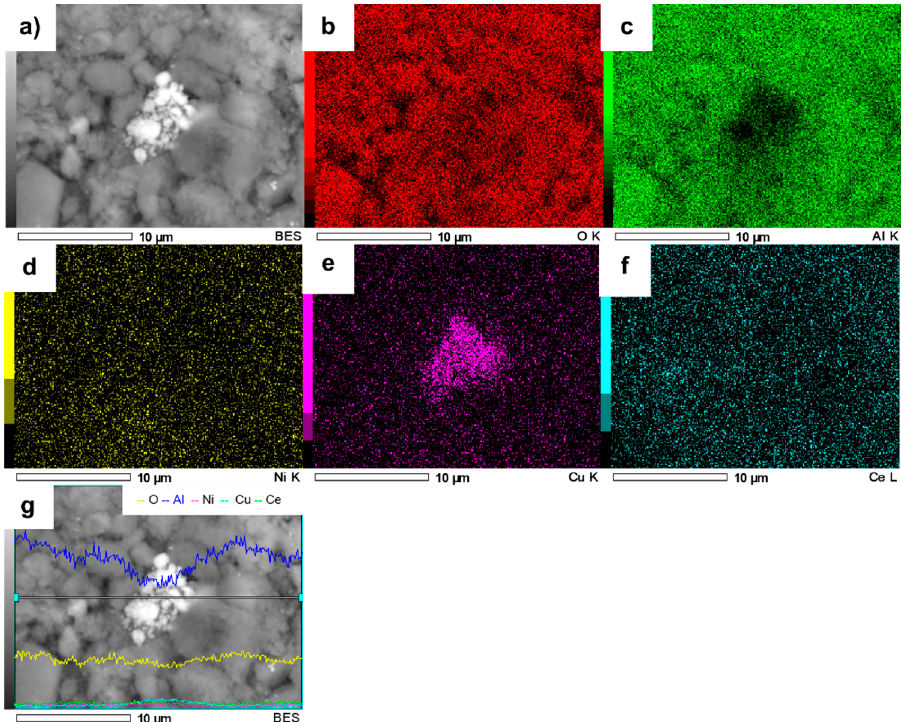
Figure 10. SEM image of NiCuAlCe ( a ) and the elemental mapping images of ( b ) O, ( c ) Al, ( d ) Ni, ( e ) Cu, ( f ) Ce and ( g ) EDS line scan of NiCuAlCe.